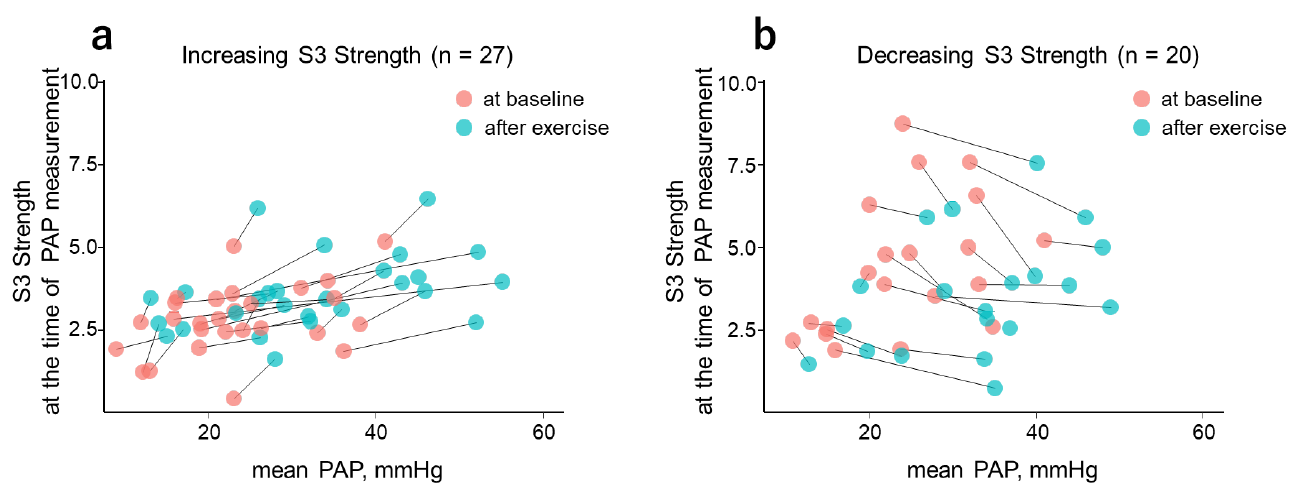
Figure 3. Scatter plot of mean PAP vs. S3 Strength at the time of PAP measurement. With the exercise-induced increase in mean PAP, S3 Strength showed increasing ( a ) and decreasing ( b ) tendencies. Light pink and blue circles represent measurement data at baseline and after exercise, respectively. S3, third heart sound; PAP, pulmonary artery pressure.